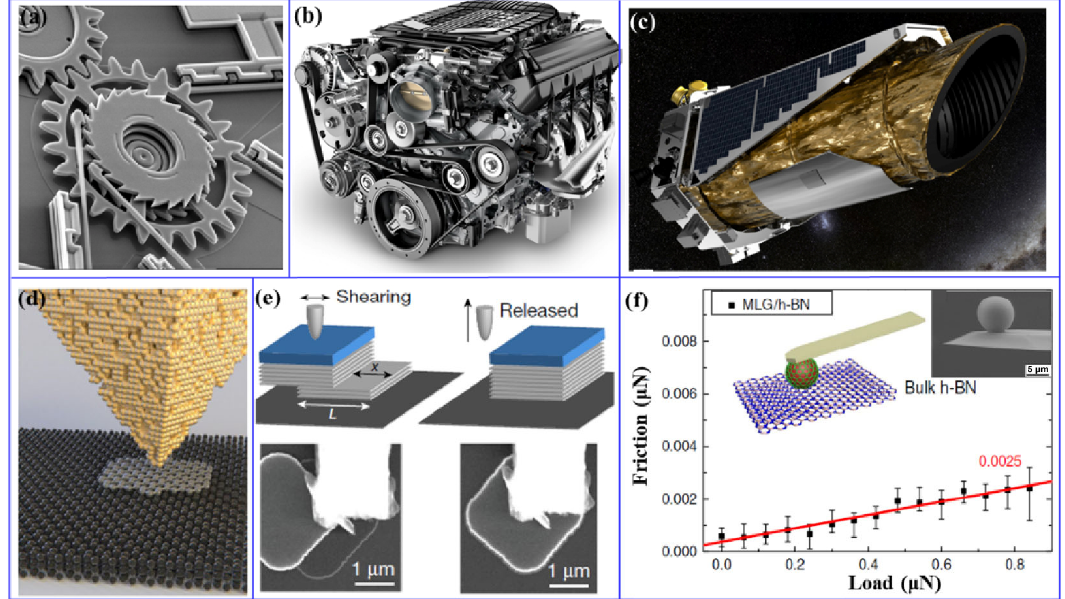
Fig. 1 (a) Micro-nano mechanical device, (b) automobile engine, (c) Kepler telescope, (d) schematic diagram of two-dimensional material solid superlubricity, (e) graphene self-recovery phenomenon, and (f) graphene-wrapped tip to achieve superlubricity. Reproduced with permission from Ref. [9] for (a, d), © Springer Nature Limited 2018; Ref. [20] for (e), © American Physical Society 2012; Ref. [7] for (f), © The Author(s)